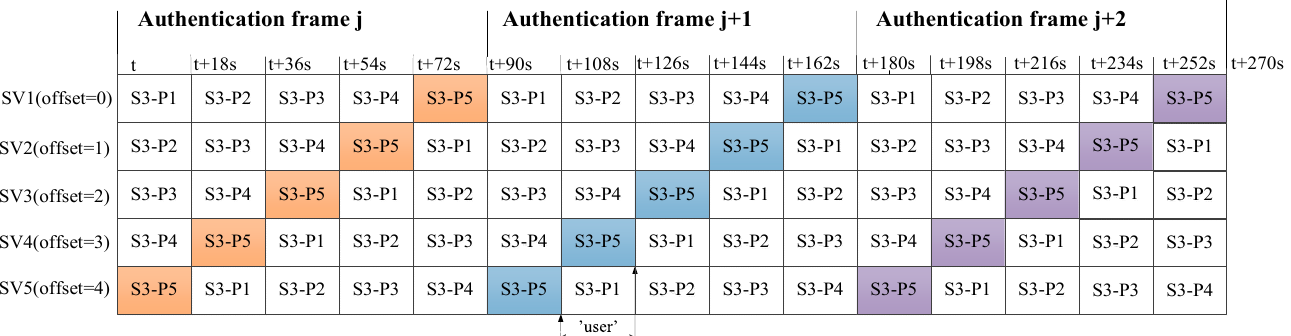
Figure 12. Satellite offset transmission.